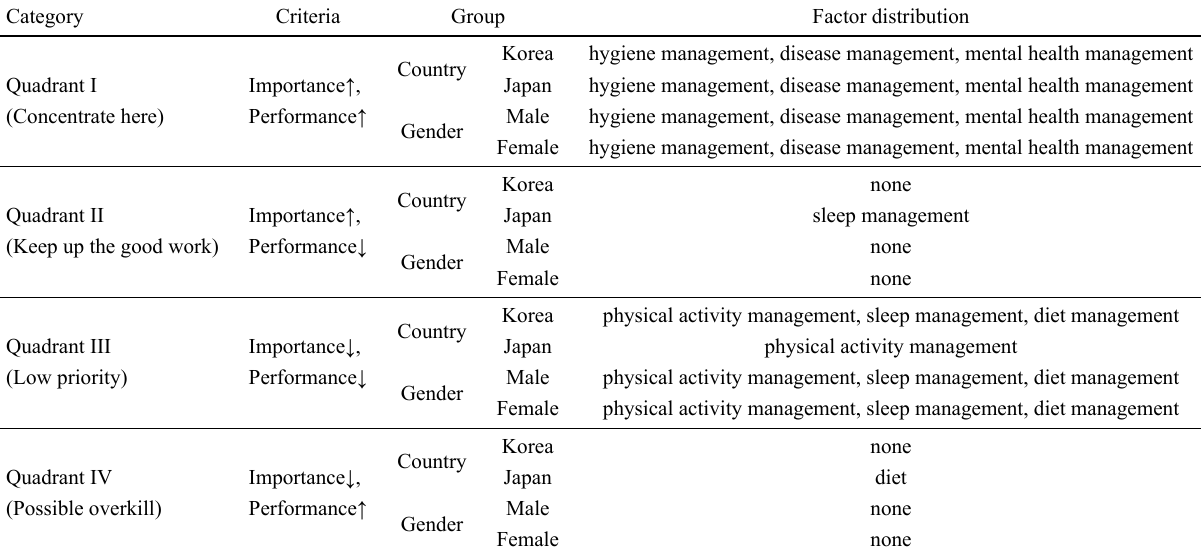
Table 5. Health perception factor distribution in Korean and Japanese, male and female